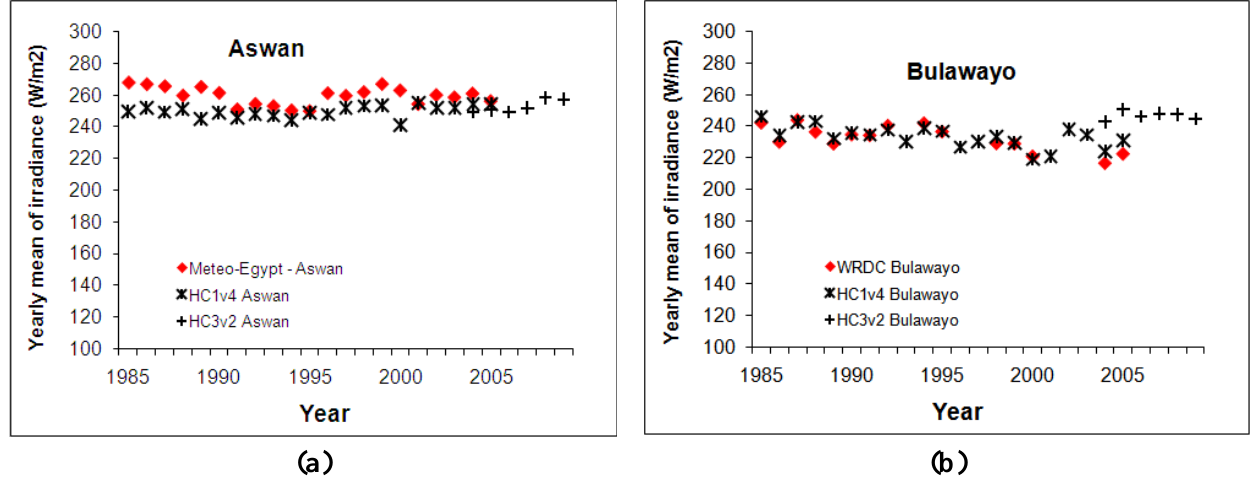
Figure 6. Yearly means of SSI from 1985 to 2009: (a) Aswan. (b)